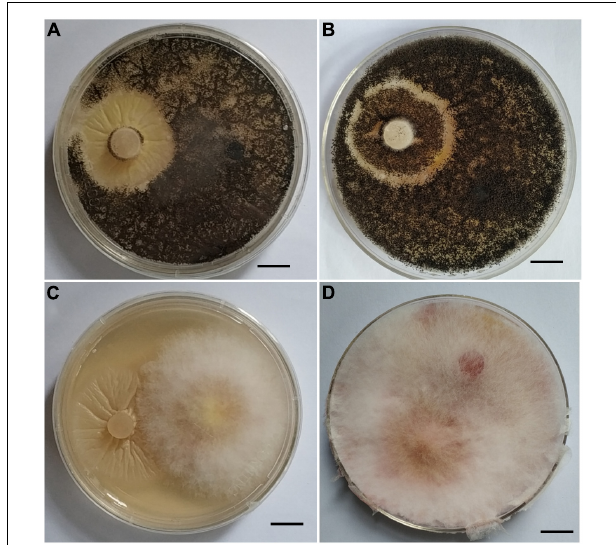
FIGURE 4 | Interaction of Piriformospora indica with Fusarium graminearum or Rhizoctonia cerealis on PDA plates. (A) P. indica and R. cerealis grow on PDA plate at the 13 and 5th, respectively; (B) P. indica and R. cerealis grow on PDA plate at the 16 and 8th, respectively. (C) P. indica and F. graminearum grow on PDA plate at the 13 and 5th, respectively. (D) P. indica and F. graminearum grow on PDA plate at the 16 and 8th, respectively.